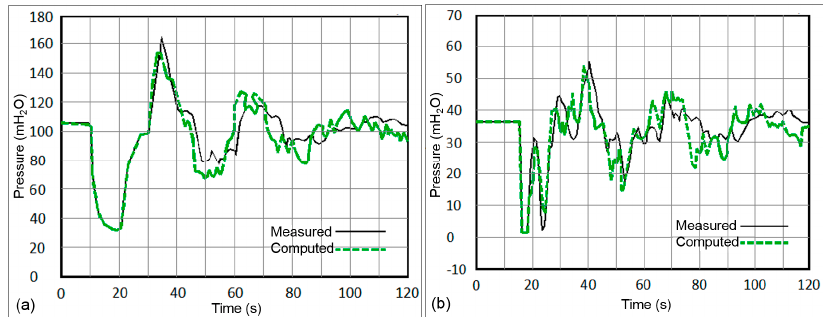
( b ) at the air valve located at station 73 + 476.